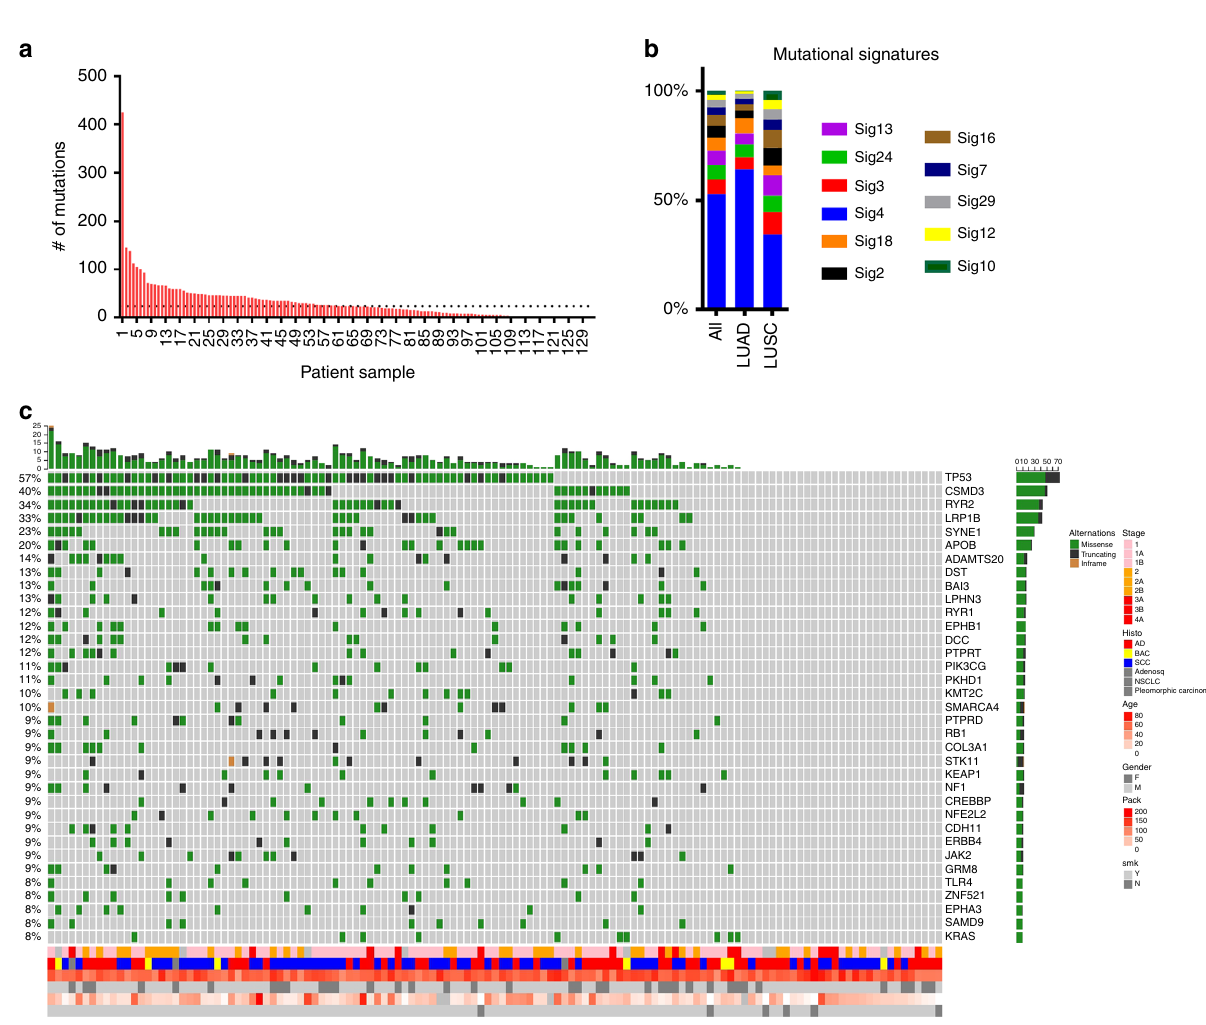
Fig. 1 Somatic mutation pro fi le of lung cancer in AAs. a Distribution of somatic mutation number across patient samples. b Summary of mutational signatures in LUAD and LUSC samples from the NCI-MD Case Control Study. c Oncoprint outlining the co-occurrence of somatic mutations in all samples in the NCI-MD Case Control Study (histo, histology; AD, adenocarcinoma; BAC, bronchioalveolar carcinoma; SCC, squamous cell carcinoma; adenosq, adenosquamous cell carcinoma; pack, pack-years of smoking; smk, smoking status). Dashed line indicates the